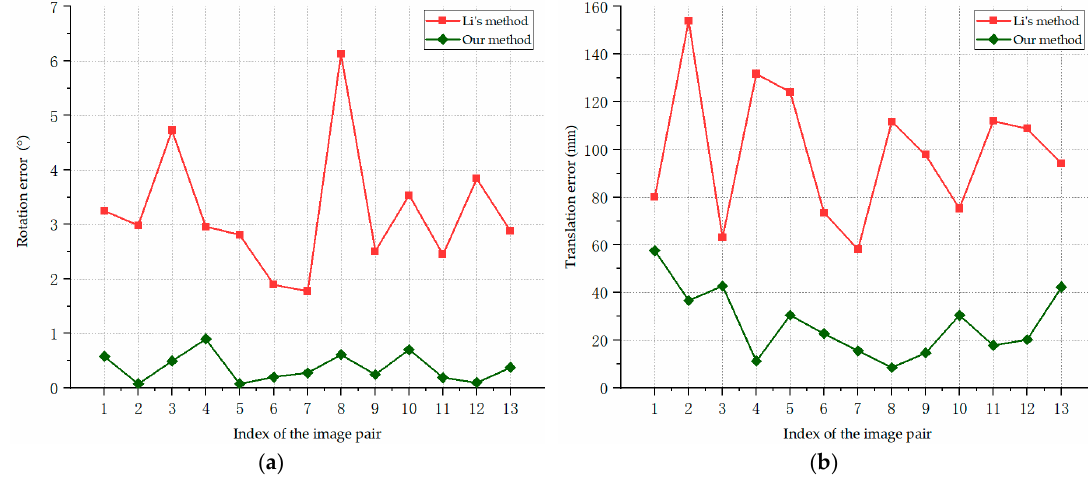
Figure 18. Pose estimation errors for the real images of the aircraft model in laboratory experiment: ( a ) rotation errors; ( b ) translation errors.